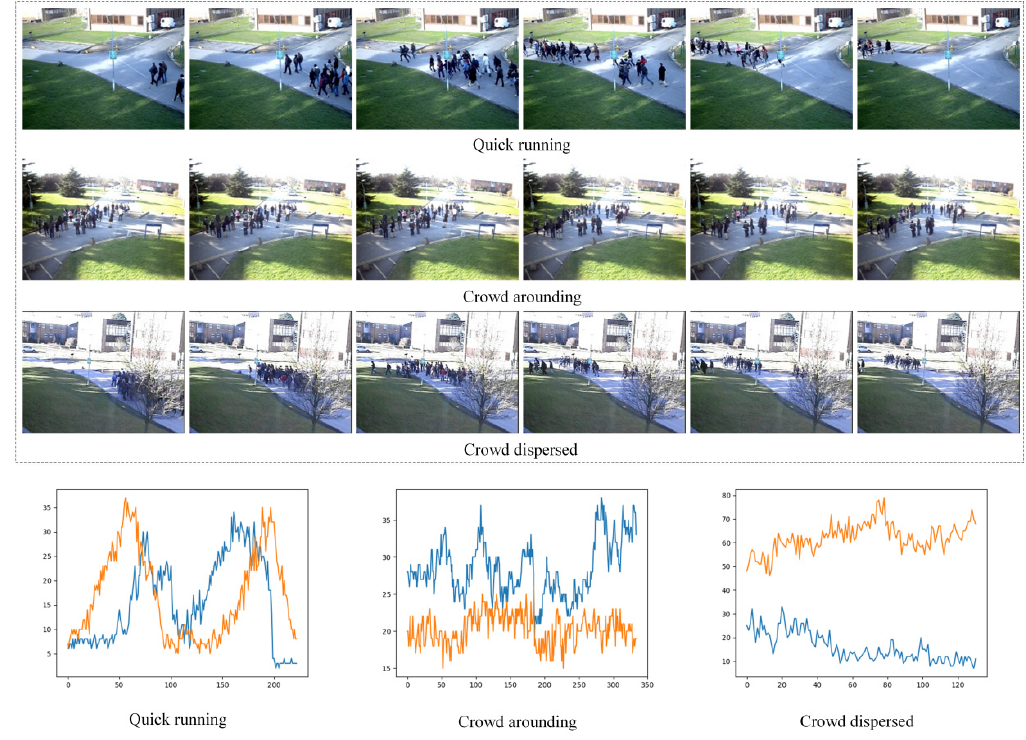
Figure 7. The examples and the statistical results of three abnormal crowd actions.